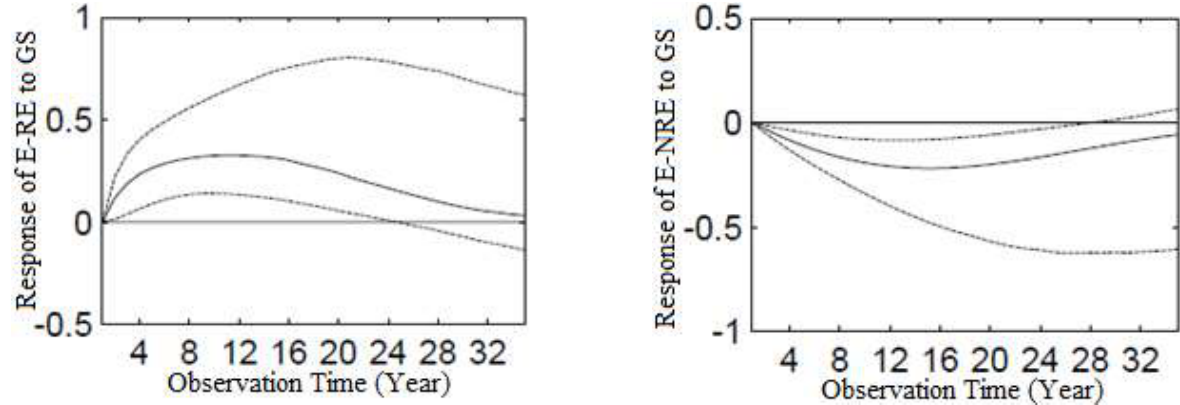
Figure 2. The impact of sustainable development shock on renewable and non-renewable energy Source: Research findings